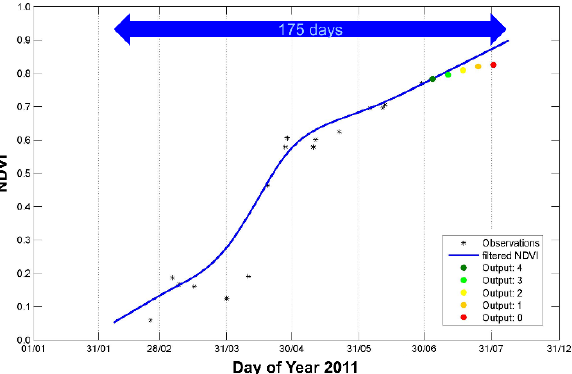
Figure 2: Processing chain of BOKU’s near real-time (NRT) filtering of MODIS NDVI time series. The steps on the left side are done only once. The processes shown on the right side are repeated every week. Together the processing leads to filtered NDVI images with associated uncertainties. Based on this primary information anomaly indicators are derived and aggregated over time and for different administrative units